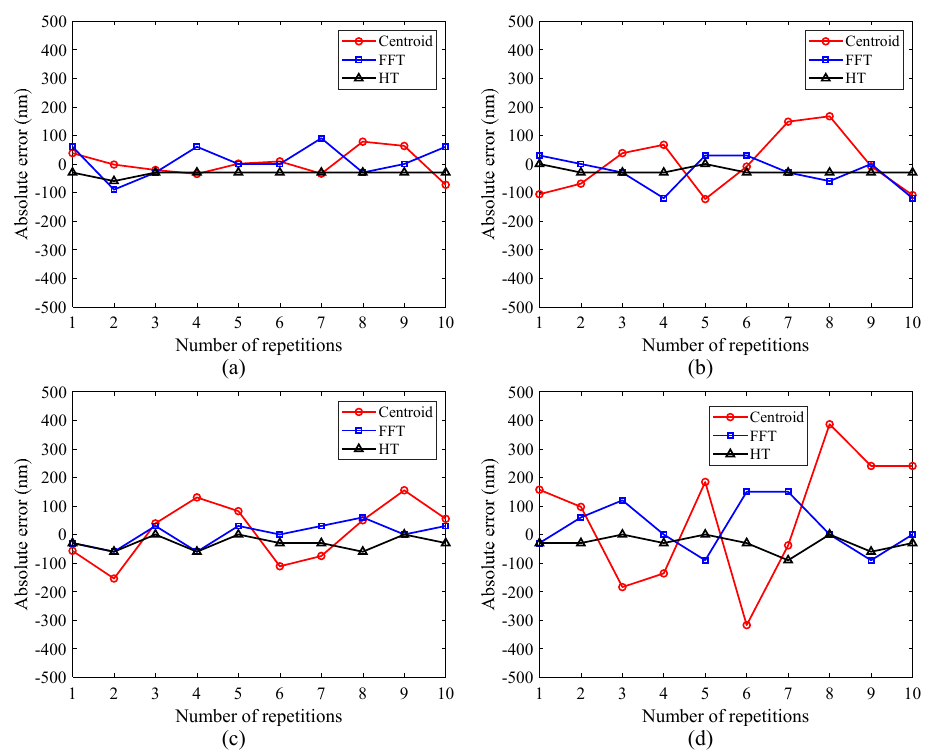
Figure 4. Simulation results of the interferometric signal under different noise levels: ( a ) 5% random noise, ( b ) 10% random noise, ( c ) 15% random noise, and ( d ) 20% random noise.